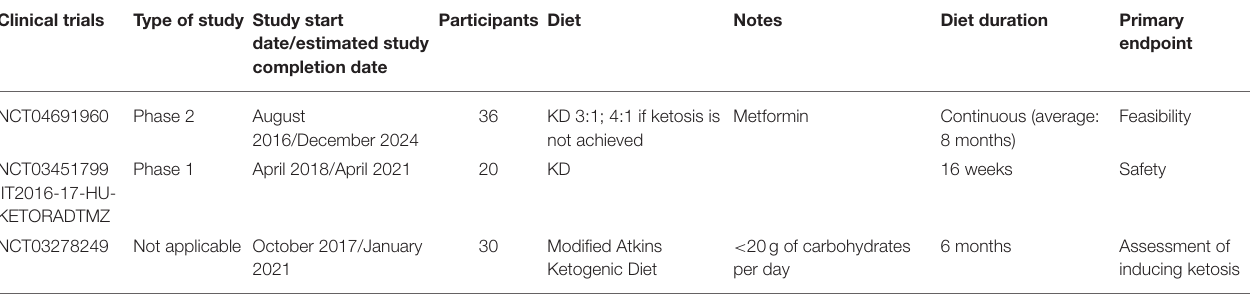
TABLE 1 | Recruiting studies on KD in